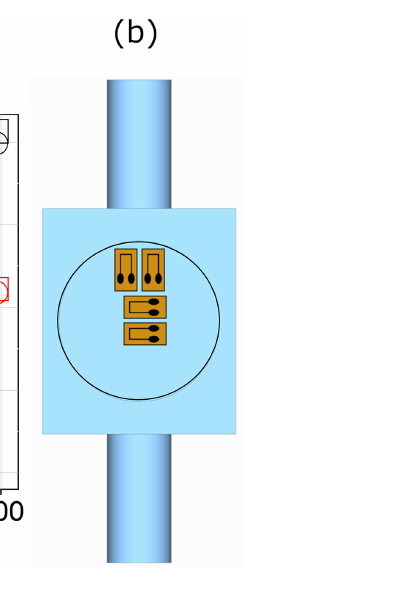
Figure 9. (a) Signal of four tension/compression force transducers vs. the applied mass. The full bridges of two transducers (red squares/circles) consist of SGs with w = 100µm and h = 2 . 5µm, resulting in k T /k L = 48 . 6%. For the full bridges of two additional trans- ducers (black squares/circles), SGs with w = 50µm and h = 18µm were used, leading to k T /k L = 5 . 5%. Panel (b) shows the positioning of the SGs on the transducer’s